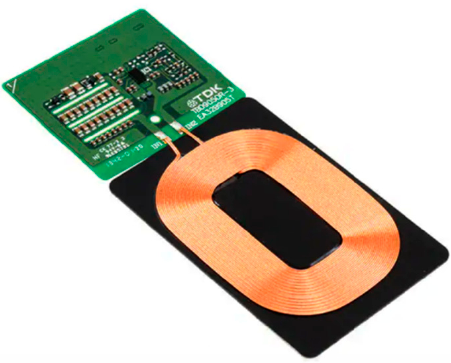
Figure 8. A planar coil used for electromagnetic energy transfer in the RF range.